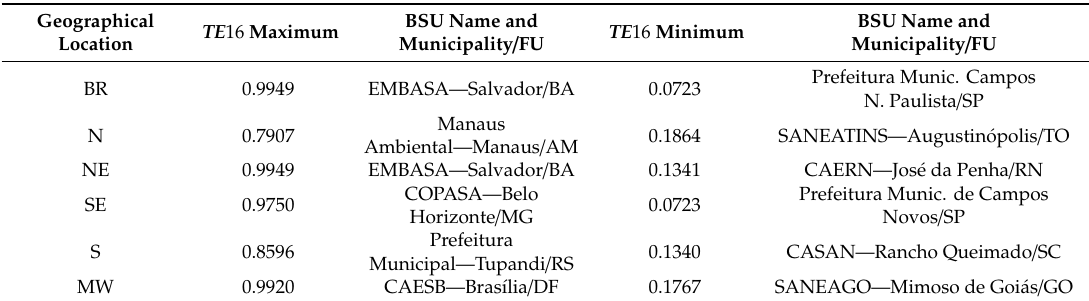
Table 5. BSU more and less e ffi cient by Brazilian region in